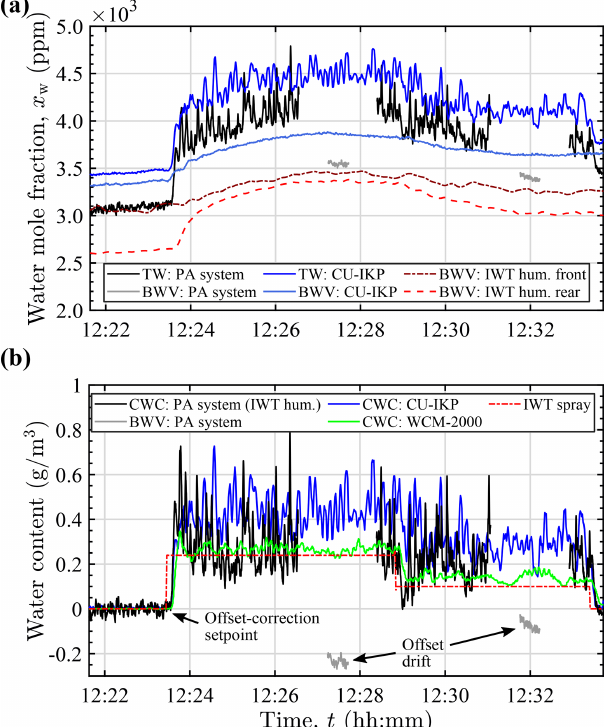
Figure 12. Water content measurements in freezing rain with a drop MVD of 550µm at − 5 ◦ C and 60ms − 1 . (a) PA instrument and CU- IKP TW and BWV mole fractions (erroneous PA instrument BWV sampling perpendicular to flow), together with BWV mole fractions calculated from the IWT humidity measurements. (b) CWC deter- mined by the PA system (in combination with IWT humidity rear ), the CU-IKP, and the hot-wire probe (WCM-2000). Spray activation is indicated by IWT spray .